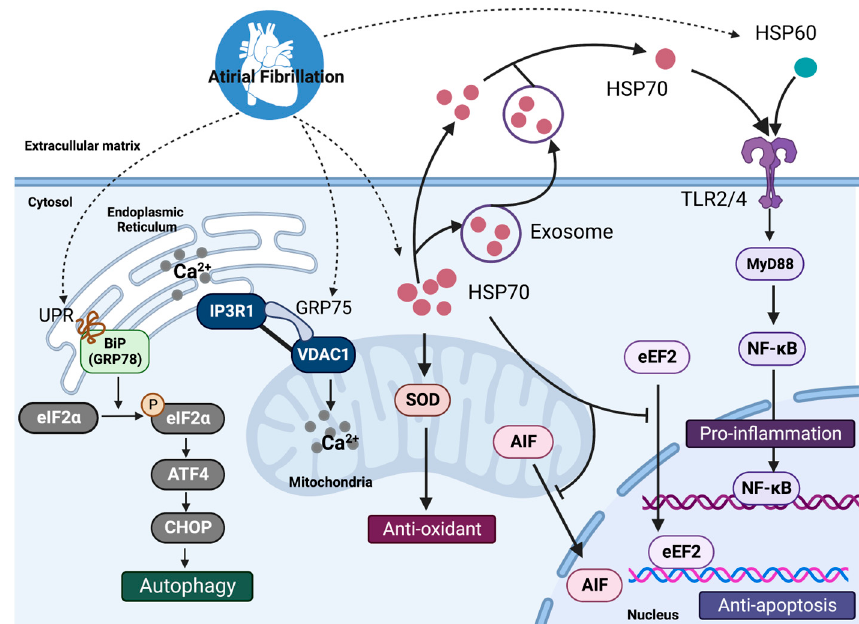
Figure 1. The mechanisms regulated by HSPs in atrial fibrillation. Intracellular HSP70s and HSP60 participate in autophagy, ER-stress, oxidative stress reaction, thereby exerting antioxidative and antiapoptotic effects and preventing atrial remodeling. However, when released into the extracellular matrix in free state, HSP60 and HSP70 bind to TLRs on the surface of the membrane to induce inflammatory responses by activating the MyD88/NF- κ B pathway. HSP, heat shock protein; UPR, unfolded protein response; GRP78, glucose-regulated protein 78; eIF2 α , α -subunit of eukaryotic initiation factor 2; ATF4, activating transcription factors 4; CHOP, CCAAT/enhancer-binding protein homology protein; IP3R1, inositol 1,4,5-trisphosphate receptors; VDAC1, voltage-dependent anion channel-1; SOD, superoxide dismutase; AIF, apoptosis-inducing factor; eEF2, eukaryotic elongation factor 2, NF- κ B, nuclear factor kappa-B, TLR4, Toll-like receptors